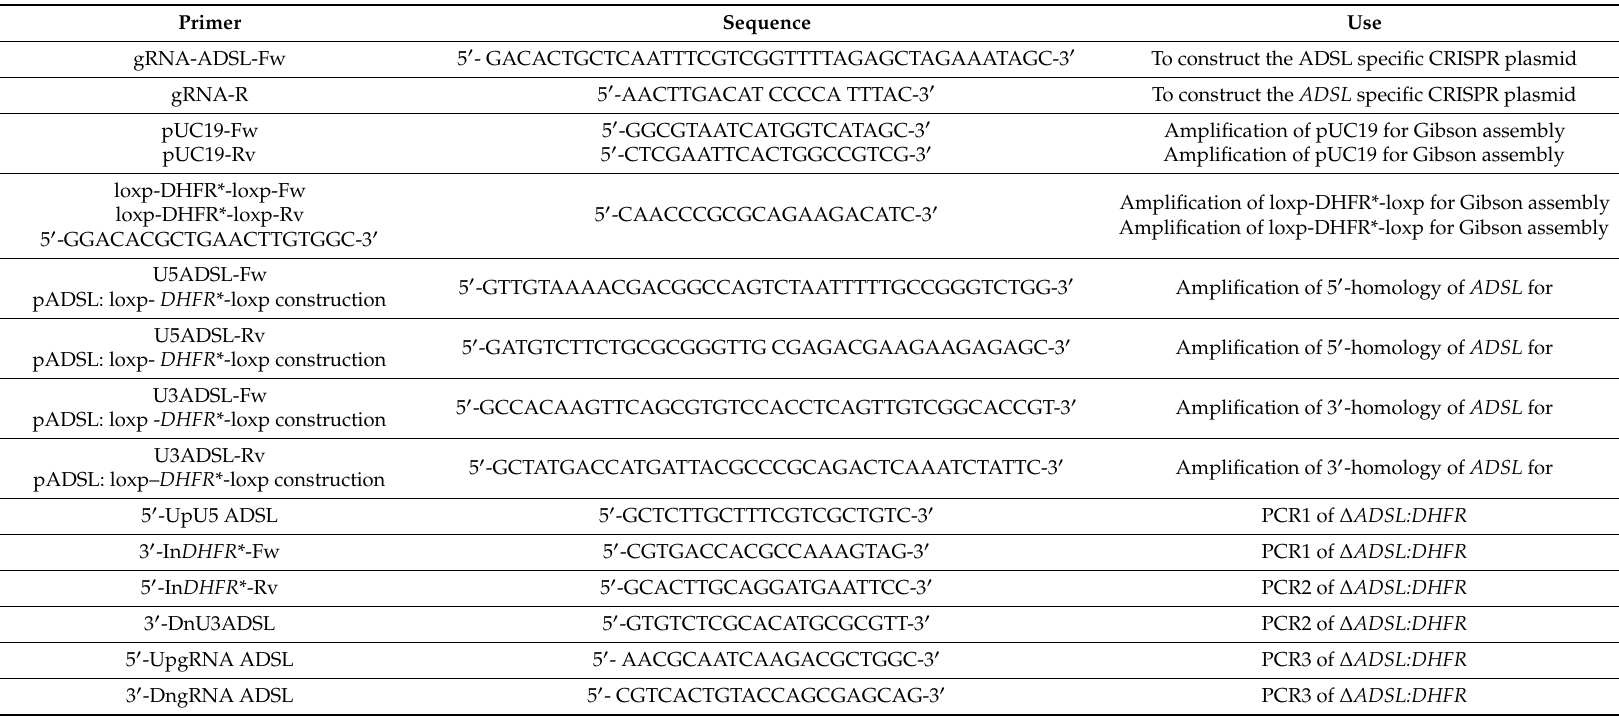
Table 1. Primers used in this